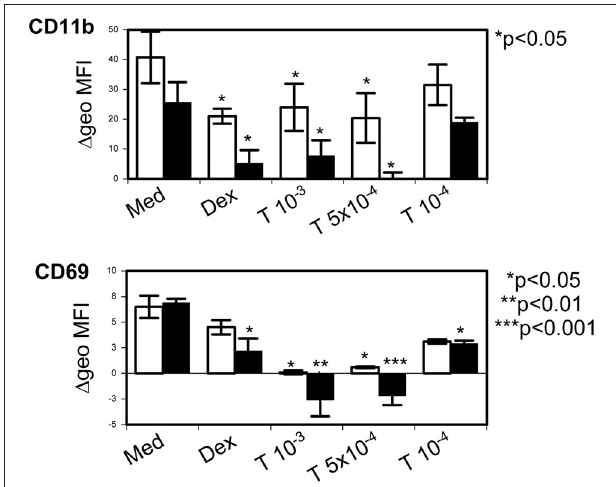
FIGURE 7 | Tetracycline hydrochloride downregulated eosinophil activation markers. Tetracycline hydrochloride (T) at indicated concentrations (in molar) downregulated CD11b and CD69 after 24h (unfilled bars) and 48h (filled bars) stimulation. P as indicated vs. control medium = Med). Dexamethasone (10 − 6 M, Dex) was less effective. 1 geometric mean fluorescence intensity ( 1 geo MFI) ± SEM ( n = 4).